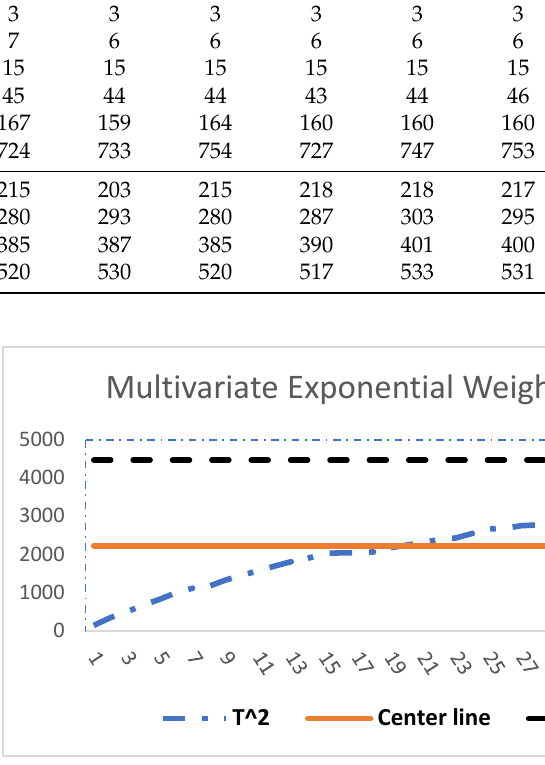
Figure 9. Optimized MEWMA control chart.